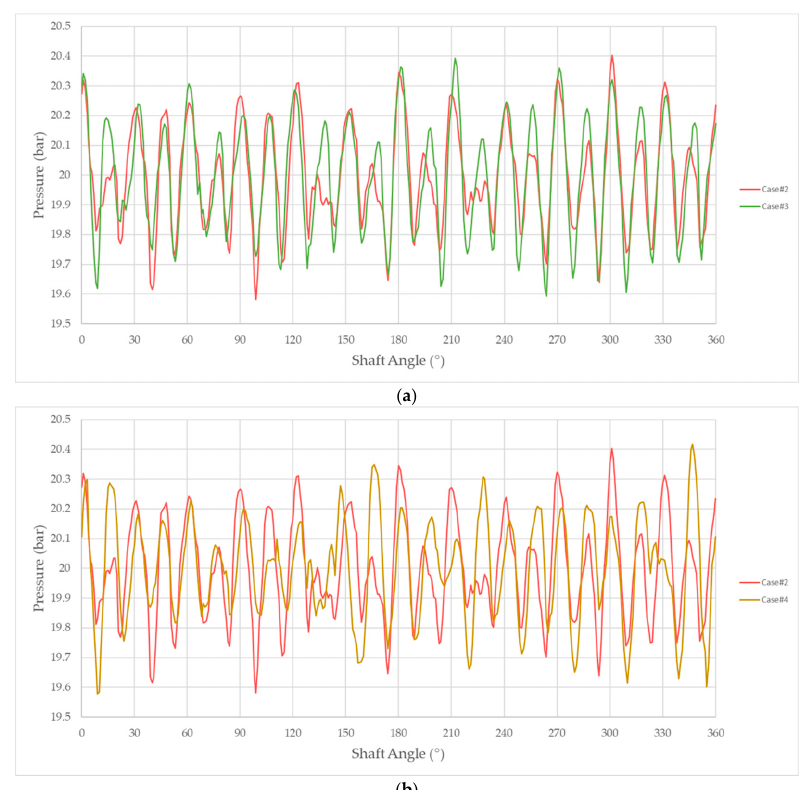
Figure 21. Supply pressure ripple: ( a ) Case #2 and Case #3; ( b ) Case #2 and Case #4.